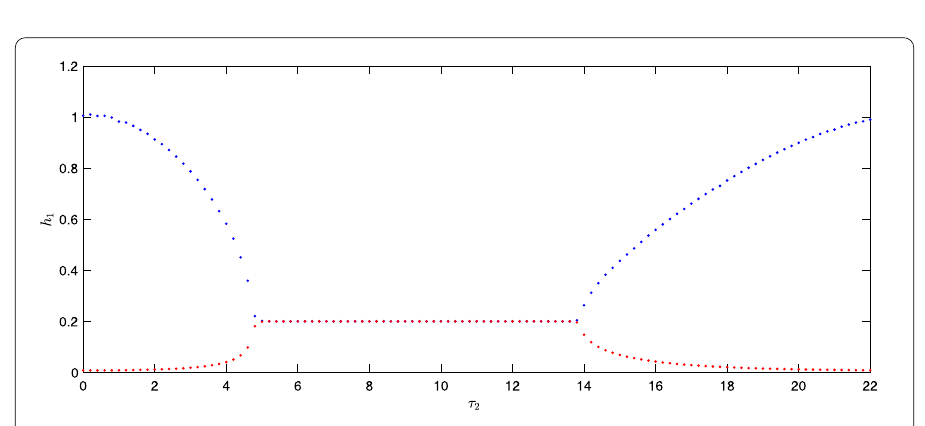
Figure 3 The τ 2 -bifurcation diagram of system (2.2) in the case A /2 < d < A . Parameter values are ε = 1, κ = 2, μ = 0.17, d = 0.038, m = 0.05, τ 1 = 2